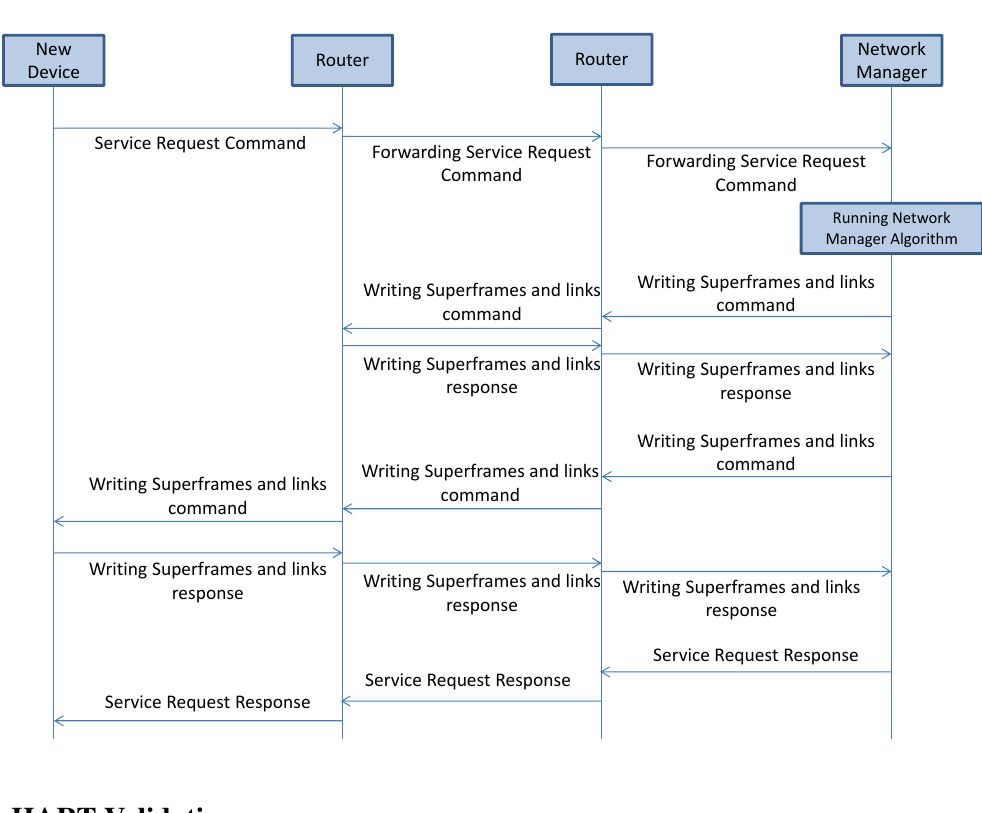
Figure 9. Service request